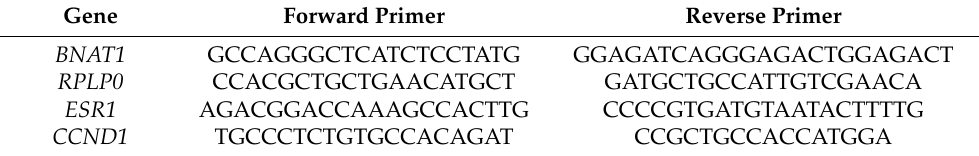
Table 1. Primers used in this